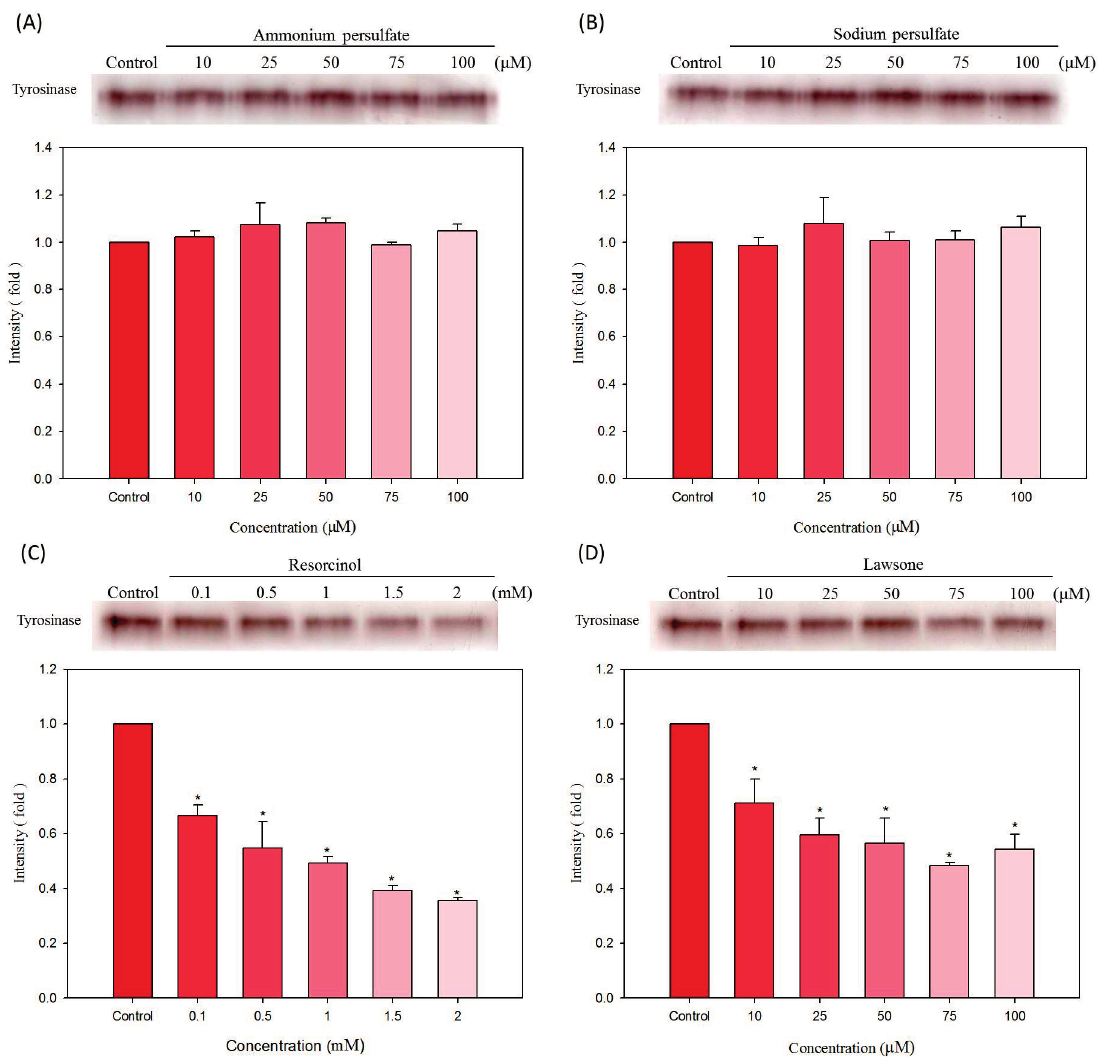
Figure 6. Effects of hair dyes on the cellular tyrosinase activity in B16-F10 cells. ( A ) ammonium persulfate; ( B ) sodium persulfate; ( C ) resorcinol and ( D )